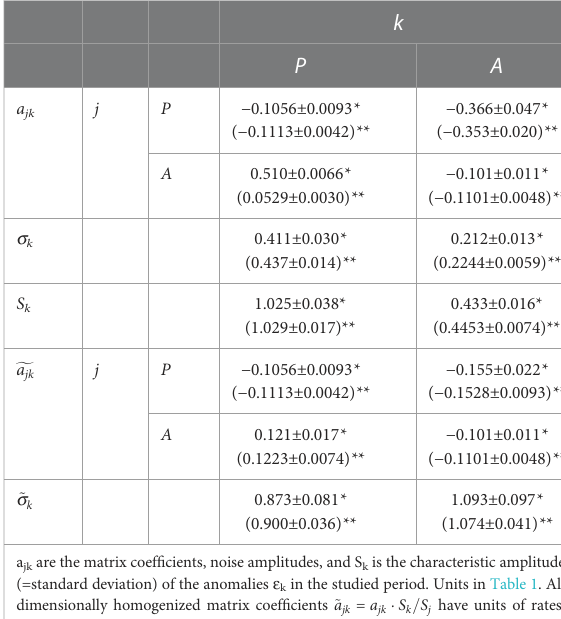
TABLE 3 Parameters (and 1-standard-deviation con fi dence intervals) obtained by the fi tting with the two-variable ReOsc+ Atlantic-Paci fi c model (Eq. 8 fi tted as explained in Section 2.3) for SODA (marked with *) and ORA-20C (with parenthesis, marked with **) reanalysis in the 1971-2000